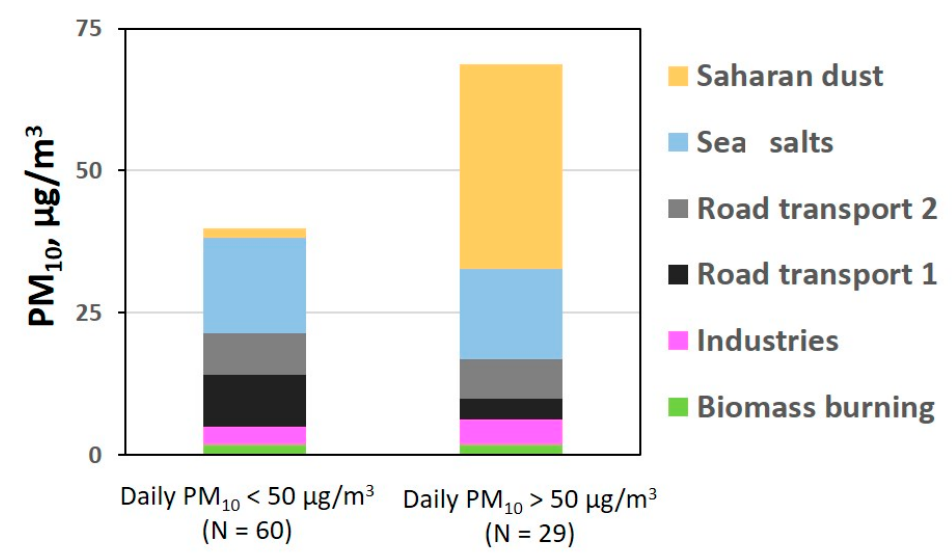
Figure 15. Contributions of the six factors obtained from the PMF analysis conducted for the urban traffic-oriented station of Fort-de-France (Renéville), out of and during PM 10 daily threshold exceedances, which could be investigated for 2018.